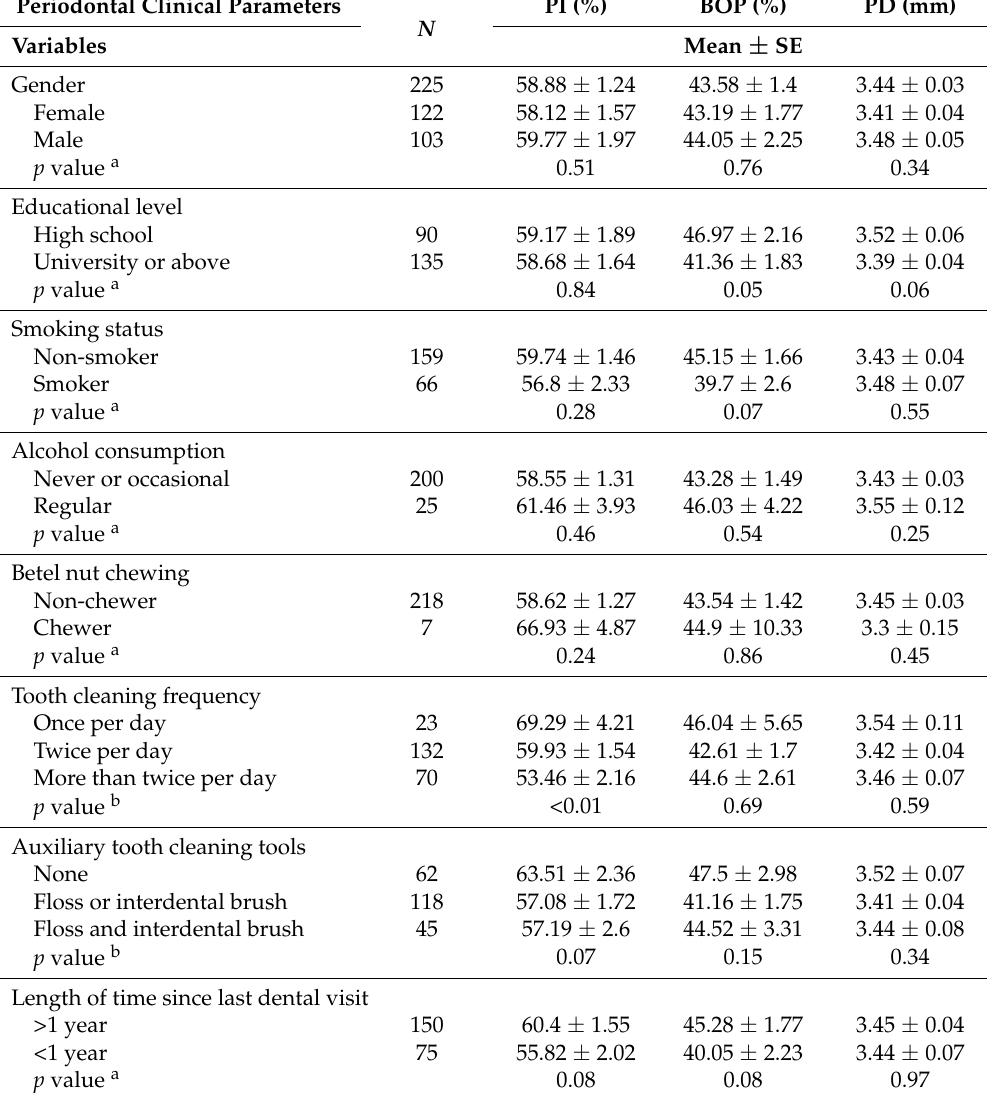
Table 1. Demographic characteristics, oral health behaviors, and distributions of periodontal clinical